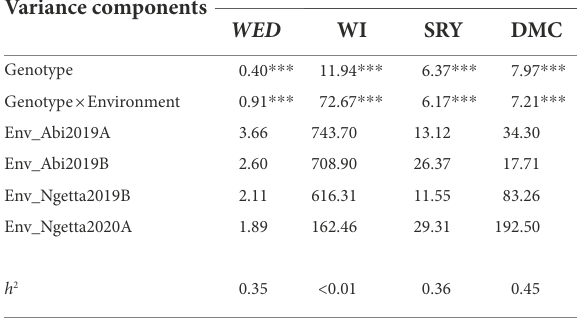
TABLE 3 Variance components, heritabilities ( 2 h ), and likelihood ratio test results for weevil severity (WED, scale 1–9), weevil incidence (WI, %), storage root yield (SRY, t/ha), and dry matter content (DMC, %) across four